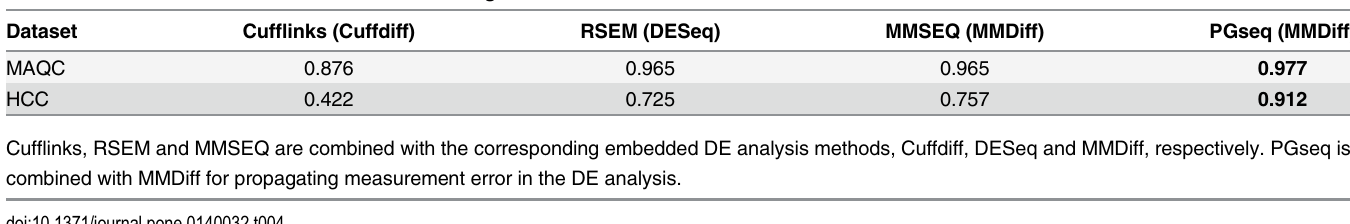
Table 4. Area under ROC curves for detection of DE genes. Dataset